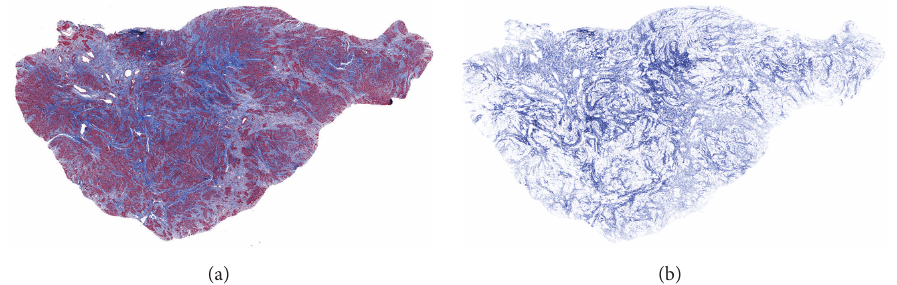
Figure 1: Image analysis of fibroid collagen content. By light microscopic examination of the H&E-stained section of this tumor, the collagen content was estimated to be more than 10% and less than 50% and thus to fall into the phase 3 category. The image on the left (a) shows the Masson’s trichrome-stained section of this tumor, while that on the right (b) depicts the markup image of the same section in which only the blue-stained collagen has been colocalized, allowing for quantitation of the percent of collagen, which was found to be 38.4%.